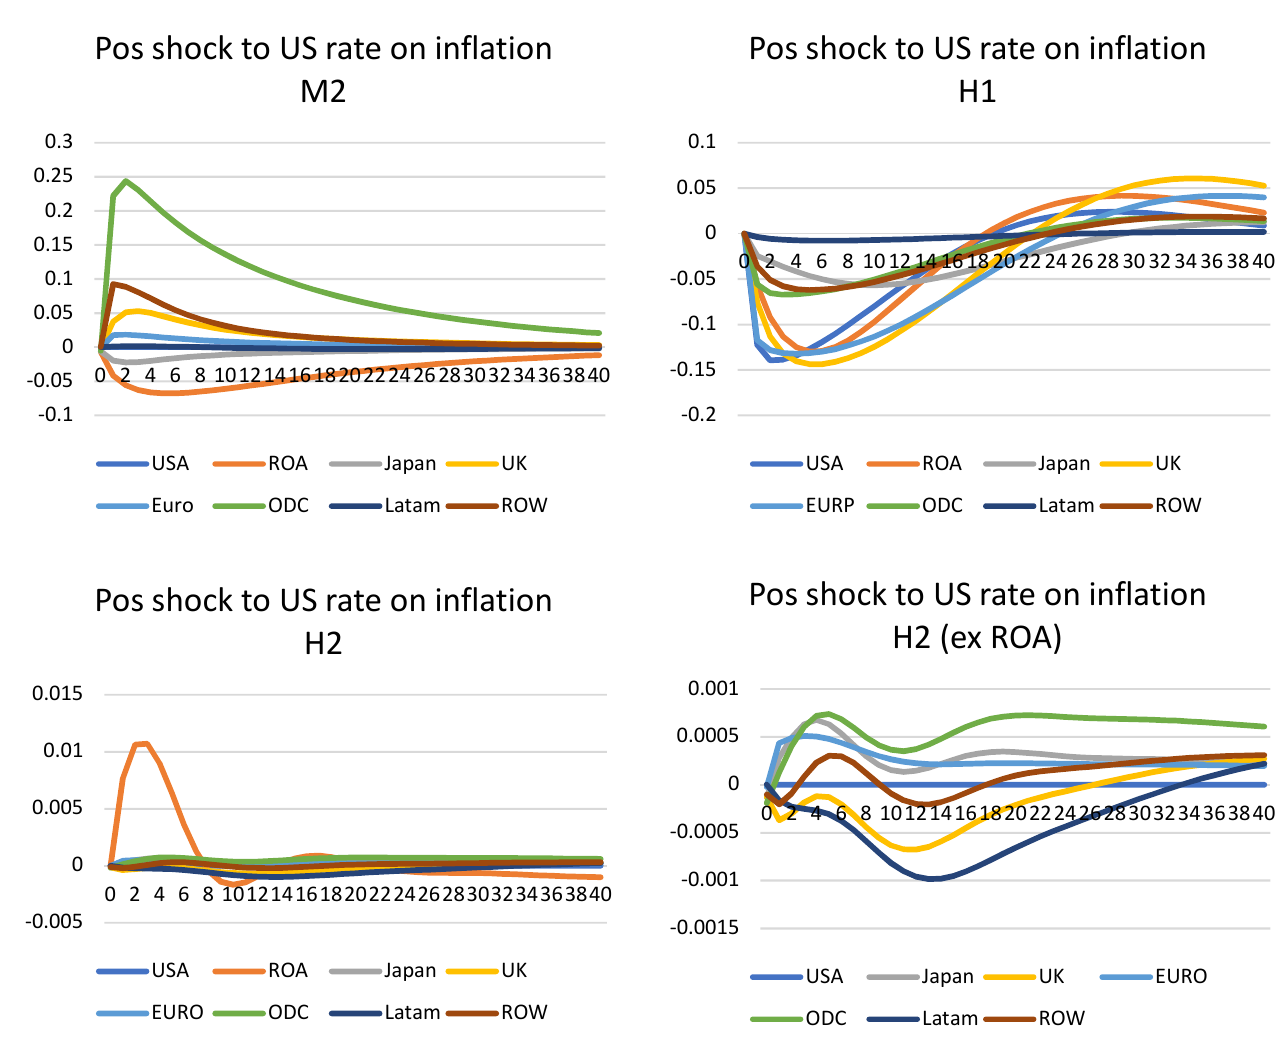
Figure 3. Positive monetary shock on inflation. For DPSS and M1, by the fourth quarter, inflation for the US was −0.18% and output −0.50% below their steady-state values. This shape is similar to the paper of Smets and Wouters (2007, Figure 6) [21]. Their model showed that a monetary policy shock would